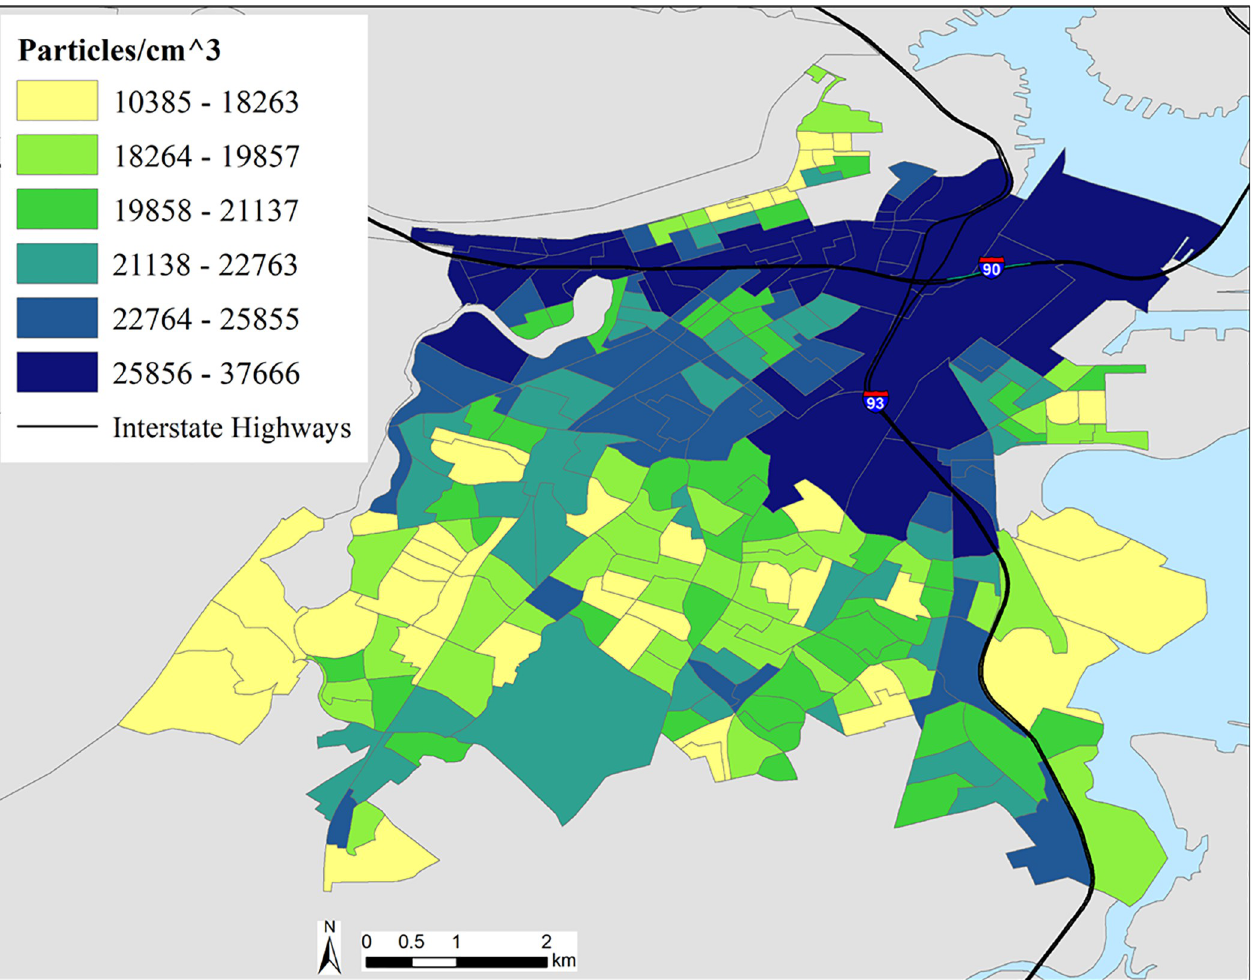
Fig 1. Spatial distribution of UFP concentrations at the block-group level in Boston, MA.